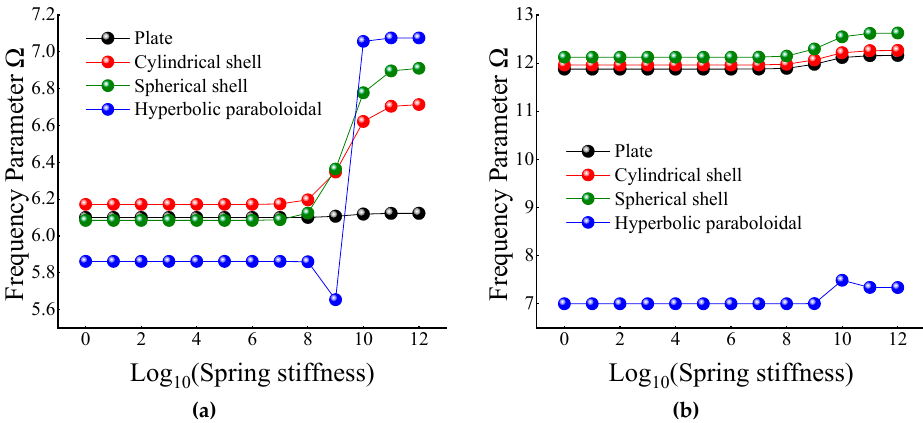
Figure 7. Variation laws of the frequency parameter Ω for composite shallow [0 ° /90 ° ] shells with various stiffness constant K u by FSDT. ( a ) m = 1; ( b ) m = 2.